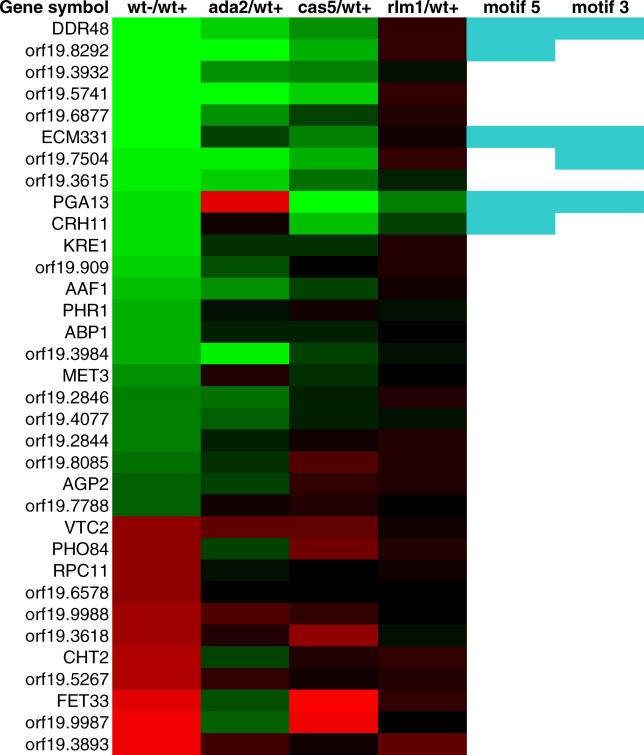
The Core Set of C. albicans Caspofungin-Responsive GenesThe expression profiles of 34 caspofungin-responsive genes that (i) exhibited a 2-fold change (p < 0.05) in response to caspofungin treatment in our experiments (Dataset S1) and (ii) exhibited a corresponding increase or decrease in response to caspofungin in the report by Liu et al. [7]. “Gene symbol” refers to entries in CGD. The columns “wt−/wt+,” “ada2/wt+,” “cas5/wt+,” and “rlm1/wt+” summarize the response of each gene in microarray comparisons of the untreated wild-type strain, the treated Caada2Δ/Δ strain, the treated Cacas5Δ/Δ strain, and the treated Carlm1Δ/Δ strain, each compared to the treated wild-type strain, respectively. Green color indicates a higher level of expression in the treated wild-type strain; red color indicates a lower level of expression in the treated wild-type strain. The degree of color saturation represents the magnitude of the expression ratio, which may be found in Dataset S1. The columns “motif 5” and “motif 3” refer to presence of the nucleotide sequences GTGGYSYKGKKG and WTGWTRWTGWTGWKSYKGW, respectively, within 999 bp of each gene's 5′ region; blue color indicates presence of the sequence. The motifs were identified through MEME analysis of CaCas5-dependent gene 5′ regions. Among noncore gene 5′ regions, motif 5 was also associated with orf19.7350, orf19.6595, orf19.753, and orf19.4771; motif 3 was also associated with orf19.13071, orf19.6595, orf19.753, orf19.7350, orf19.4771, and orf19.711.